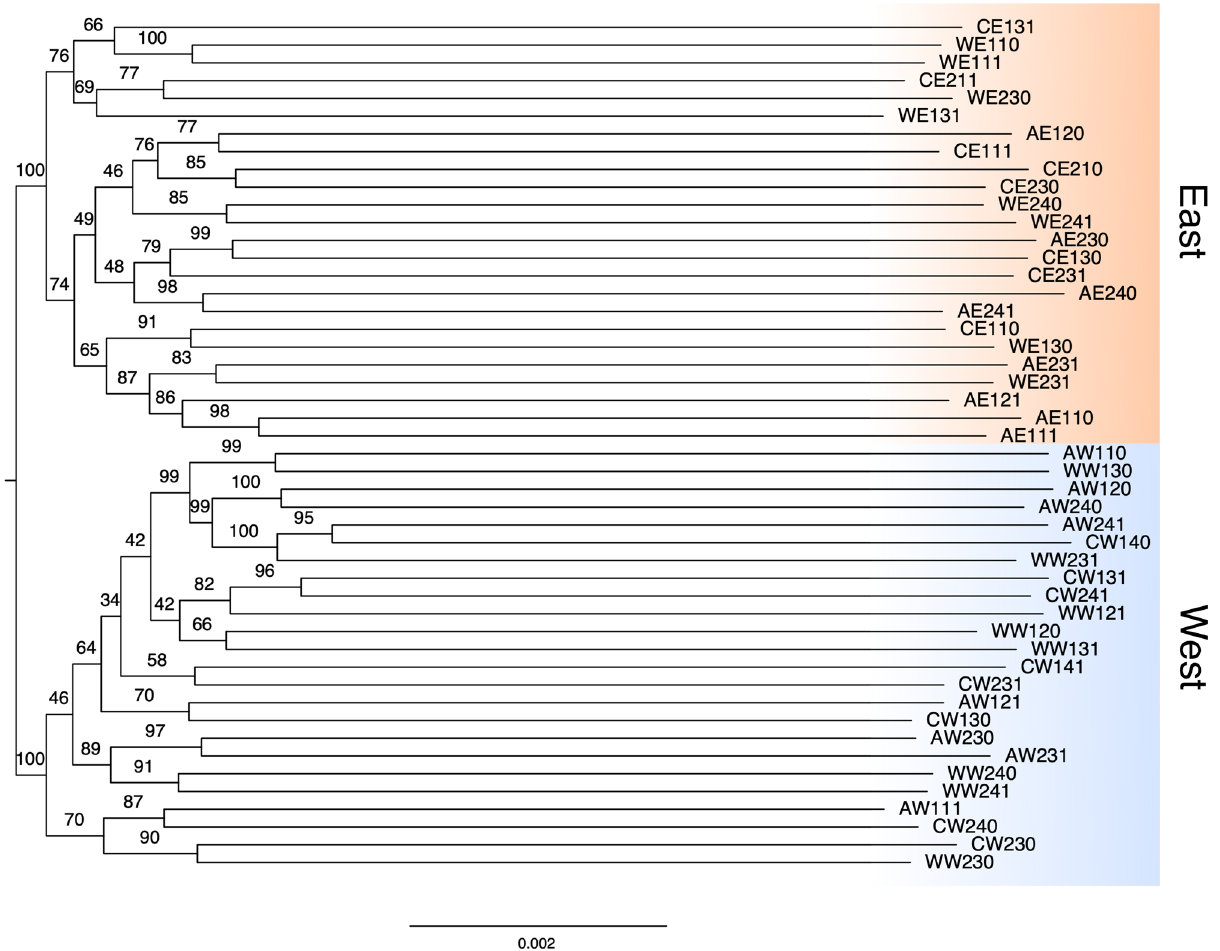
Figure 3. Maximum likelihood multilocus phylogenetic tree of the sample alleles used in this experiment. The tree was built from a concatenated supermatrix of aligned protein coding regions (434,025 sites) derived from 407 BUSCO single-copy orthologues. Ultrafast bootstrap values (1000 replicates) are indicated on branches. CE = Control for Eastern lineage, WE = Water for Eastern lineage, AE = Air for Eastern lineage, CW = Control for Wastern lineage, WW = Water for Western lineage, AW = Air for Western